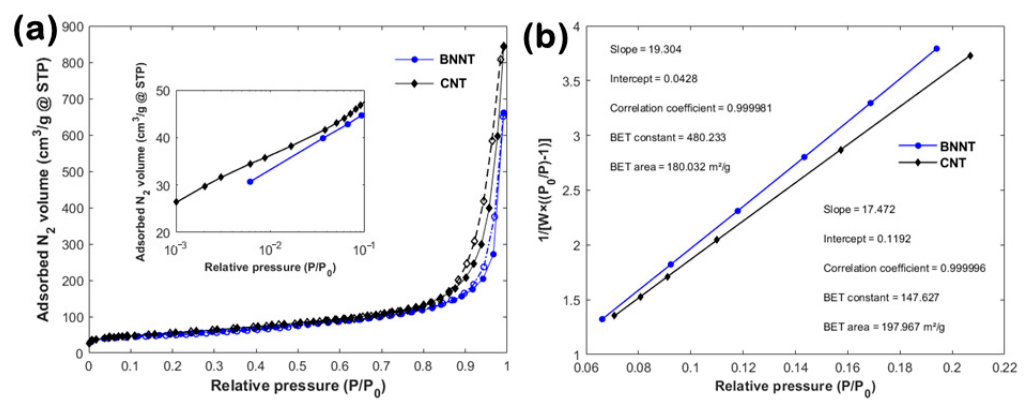
Figure 6. ( a ) N 2 adsorption (solid symbols) and desorption (open symbols) isotherms recorded at − 196 ◦ C for the BNNTs and CNTs; the inset shows the N 2 adsorption behavior at the lower relative pressures ( P / P 0 < 10 − 1 ) using a logarithmic scale and ( b ) linear multi-point BET plots calculated at the relative pressure range 0.06 < P / P 0 <